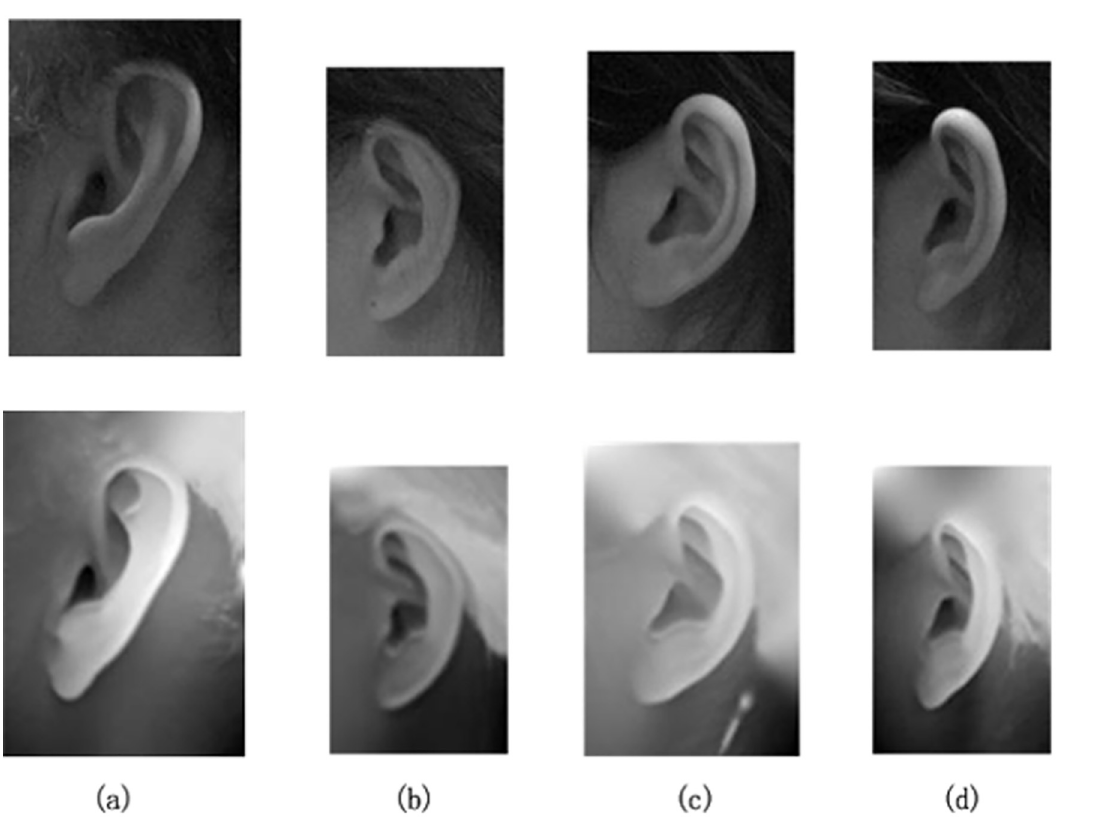
Fig 3. Examples of extracted ear